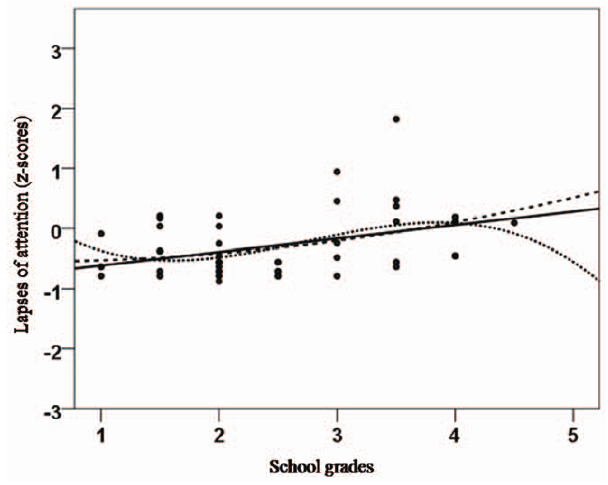
Figure 4. Correlation between scholastic achievement (school grades in German) and the z-scores of lapses of attention as assessed by the KITAP [ 18,33 ] . A linear trend was indicative of an increase in lapses of attention with a decline in school grades (1=‘‘very good’’; 6=‘‘worst’’), and a quadratic and cubic trend was indicative of a plateau starting between the school grades 1 and 2.